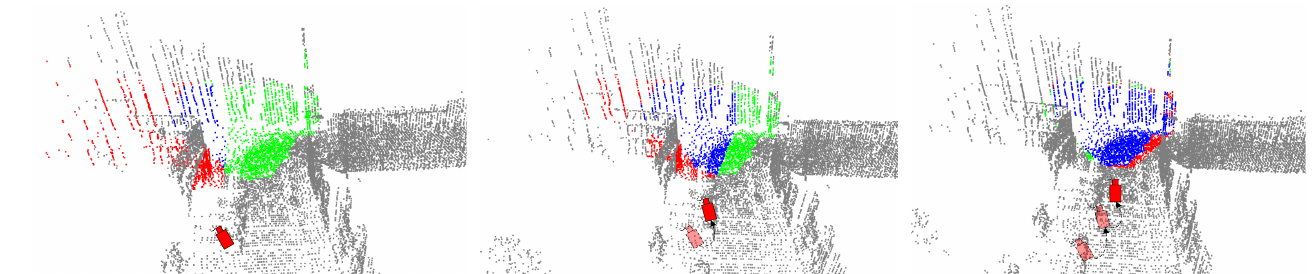
Figure 6. Visualizations of the AgentI2P at iteration 0/5/10 from left to right. Along with the continu- ous decision making of our agent, the proportion of overlapping points is increasing, and the camera is converging to the correct pose. Grey/green/red/blue indicate Map/Target/Source/overlaid point cloud respectively.